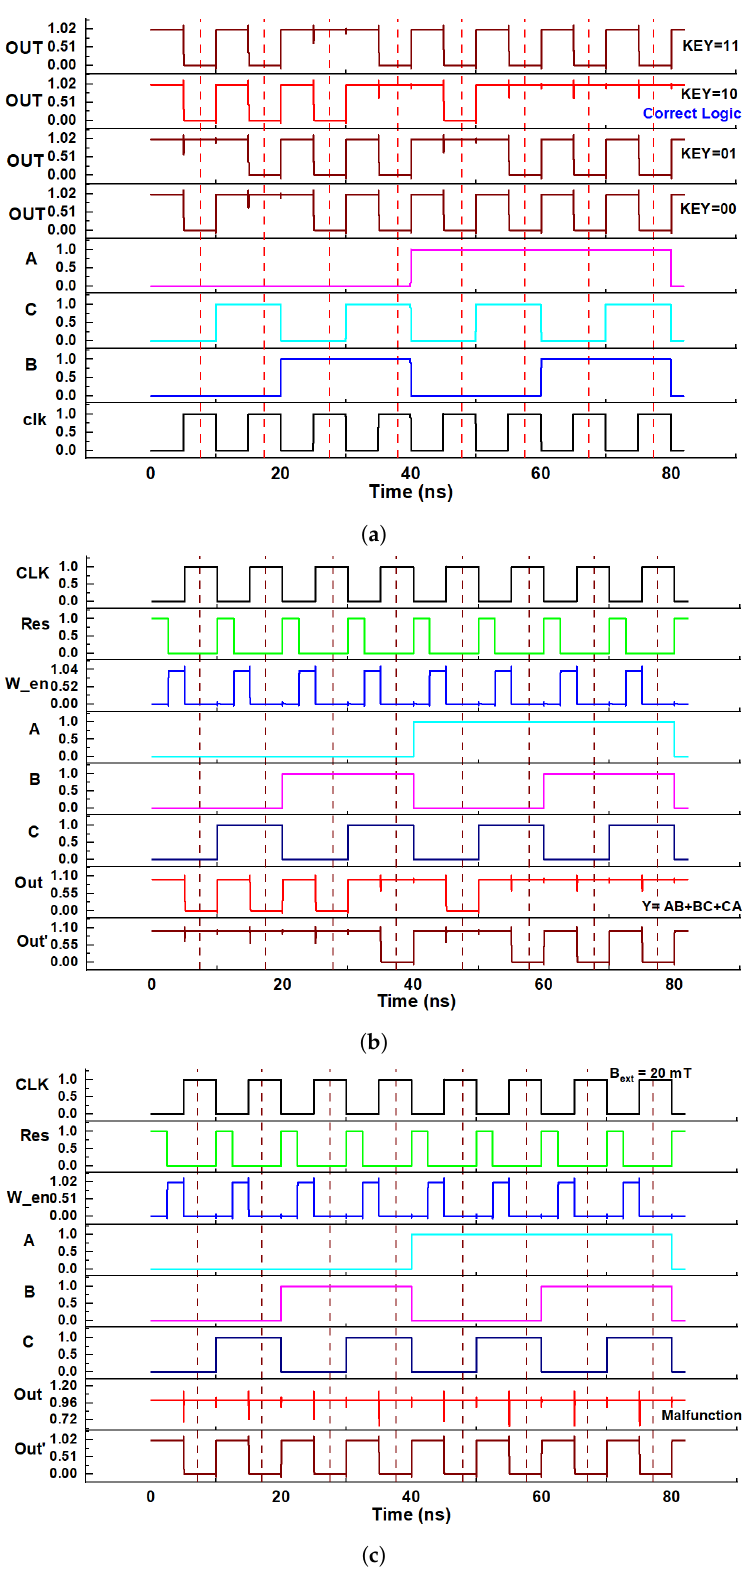
Figure 8. ( a ) Logic-locking mechanism with different key values. ( b ) Hardware Trojan block wave- forms in logic-locking circuit (hidden behavior). ( c ) Hardware Trojan block waveforms in logic-locking circuit with external triggering (malfunction